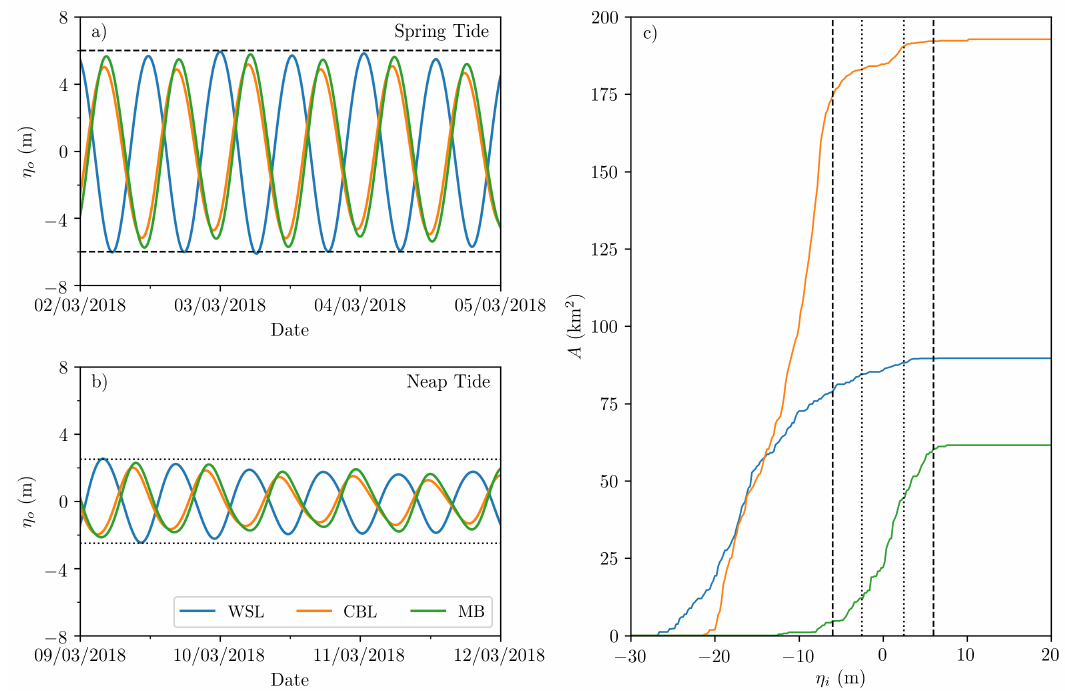
Figure 3. Ambient tidal elevations η o (m) in three scheme locations for ( a ) spring and ( b ) neap tides, and ( c ) the relationship between basin surface plan area A (km 2 ) and basin elevation η i (m) in the corresponding tidal power